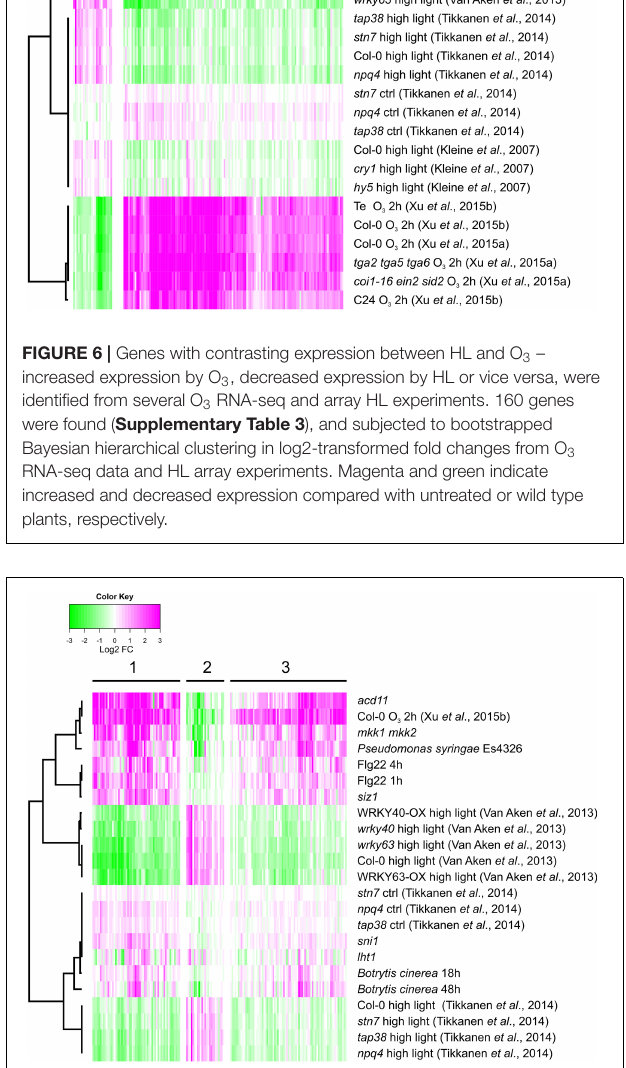
FIGURE 7 | Pathogen regulation of genes with contrasting expression between HL and O 3 . Gene expression data sets include treatments with pathogens or flg22. In addition, mutants undergoing spontaneous cell death were included (see section “Materials and Methods” for full list of experiments). Genes were subjected to bootstrapped Bayesian hierarchical clustering of log2-transformed fold changes. Magenta and green indicate increased and decreased expression compared with untreated or wild type plants,